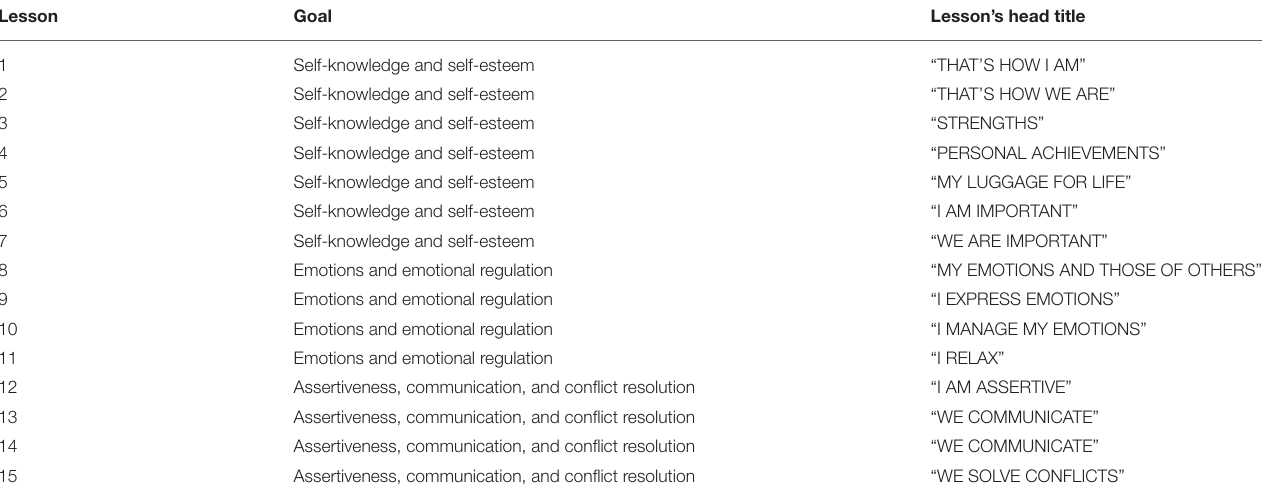
TABLE 1 | Goals of the program to impart socio-emotional competencies.